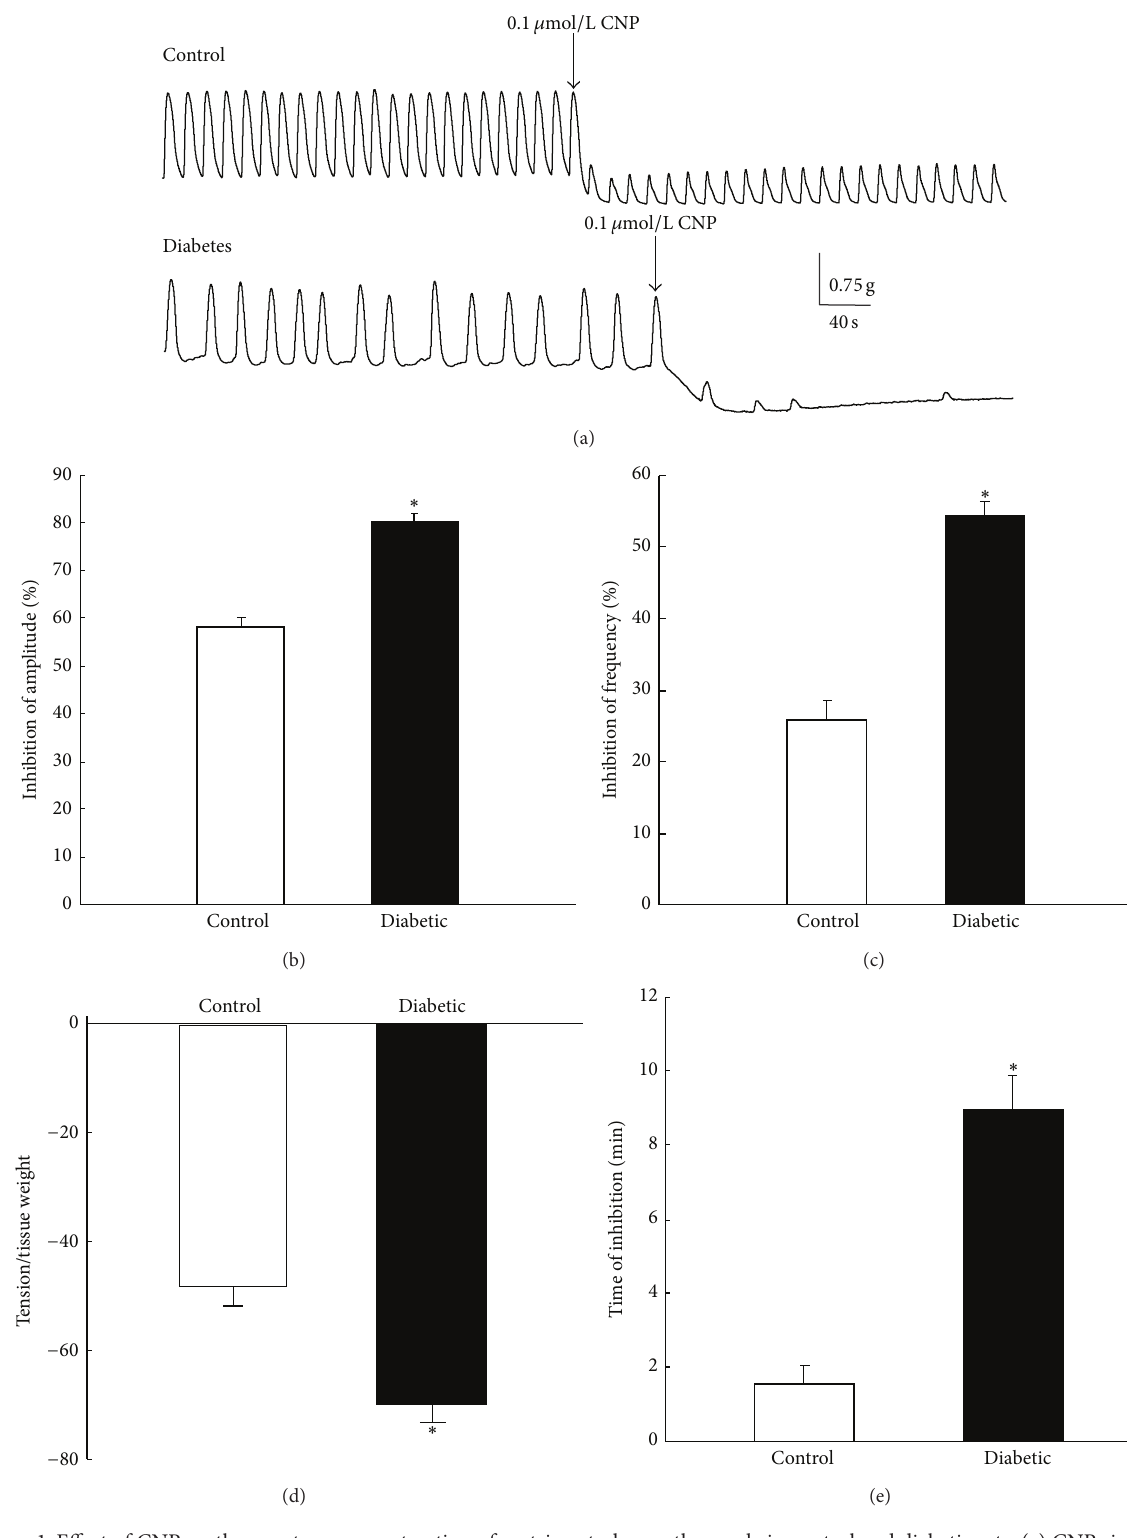
Figure 1: Effect of CNP on the spontaneous contraction of gastric antral smooth muscle in control and diabetic rats. (a) CNP significantly inhibited the spontaneous contraction of gastric antral smooth muscle in both control and diabetic rats. (b) CNP caused significantly more inhibition on the amplitude of the contraction in diabetic rats than in controls ( 𝑛 = 8 , 𝑃 < 0.01 ). (c) CNP caused significantly more inhibition on the frequency of the contraction in diabetic rats than in controls ( 𝑛 = 8 , 𝑃 < 0.01 ). (d) CNP decreased the basal tension, which was more significantindiabeticratsthanincontrols( 𝑛 = 8 , 𝑃 < 0.01 ).(e)ThedurationofCNP-inducedinhibitionofgastricsmoothmusclecontraction was significantly longer in diabetic rats than in controls ( 𝑛 = 8 , 𝑃 < 0.01